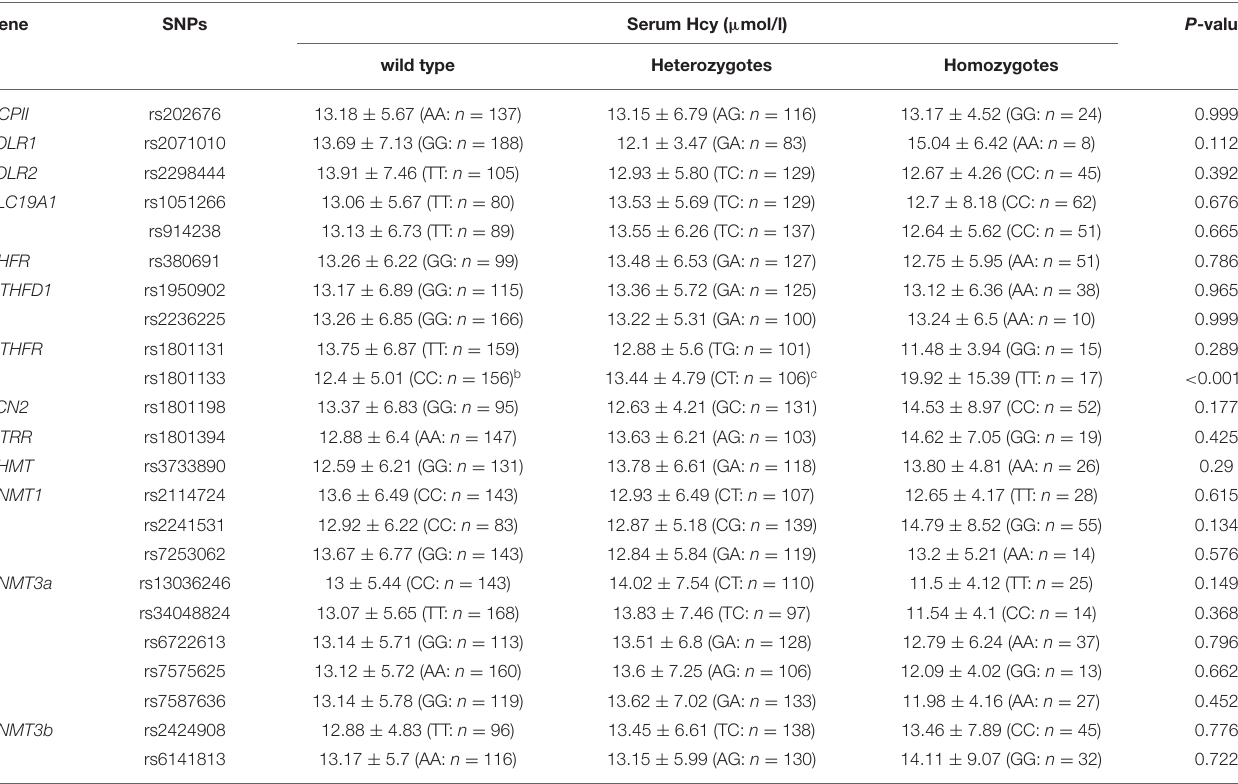
TABLE 2 | Effects of SNPs in genes encoding OCM-related enzymes on Hcy levels in patients with epilepsy. Gene SNPs Serum Hcy ( µ mol/l) P -value wild type Heterozygotes Homozygotes